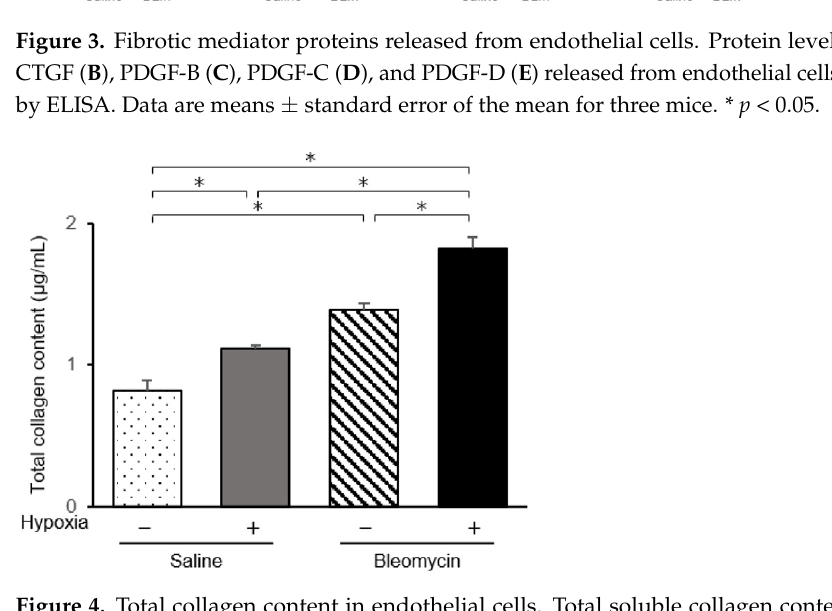
Figure 4. Total collagen content in endothelial cells. Total soluble collagen content in the culture medium from endothelial cells isolated from saline- and bleomycin-treated lungs was quantified by the Sircol assay. Results are means ± standard error of the mean from three mice per group. * p < 0.05.